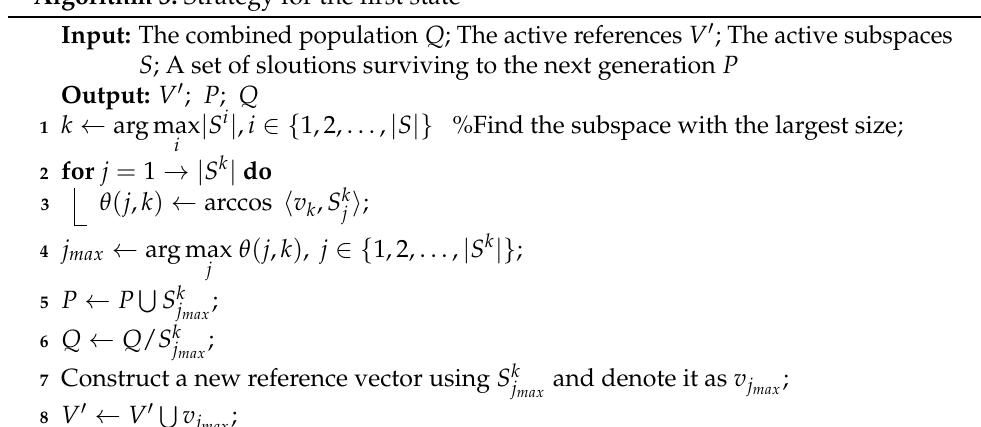
Algorithm 3: Strategy for the first